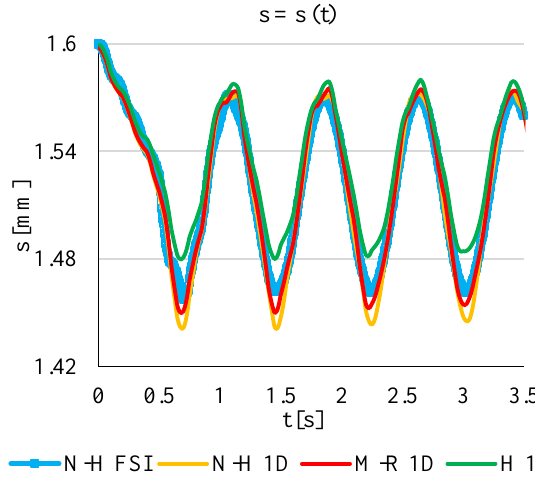
Fig. 22. Wall thicknesses s of the thick-walled